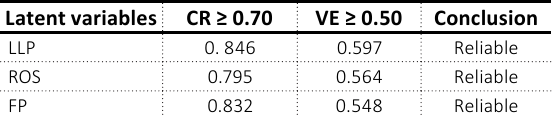
Table 5. Reliability of latent